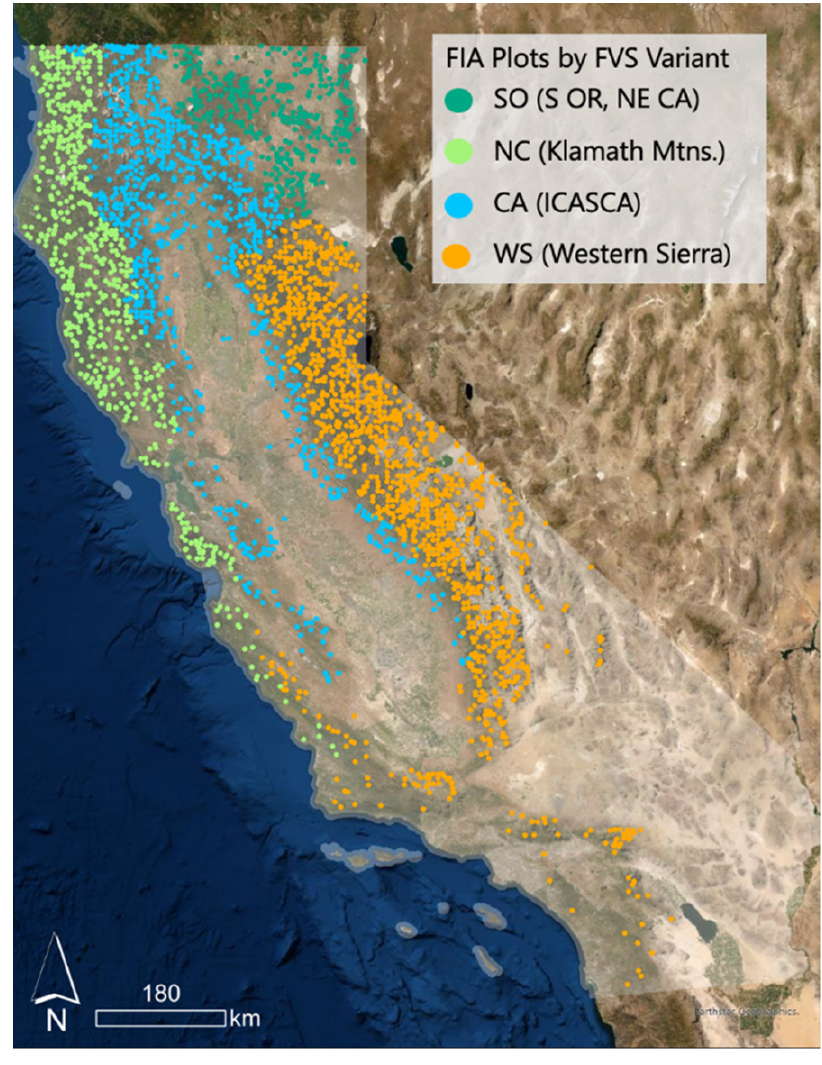
Figure 1. Approximate locations of FIA plots in California used for this analysis, shaded by FVS Variant: SO=South Central Oregon and Northwest California, NC=Klamath Mountains, CA=Interior California and Southern Cascades, WS=Western Sierra.